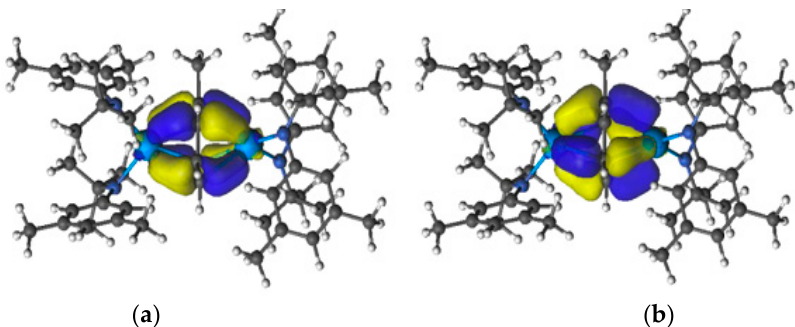
Figure 17. Singly occupied δ bonding natural MOs from the (µ-toluene)U 2 (N[ t Bu]Ar) 4 complex in its quintet state. ( a ) SOMO − 4 and ( b ) SOMO − 5 (reprinted with permission from [16], American Chemical Society, 2013).